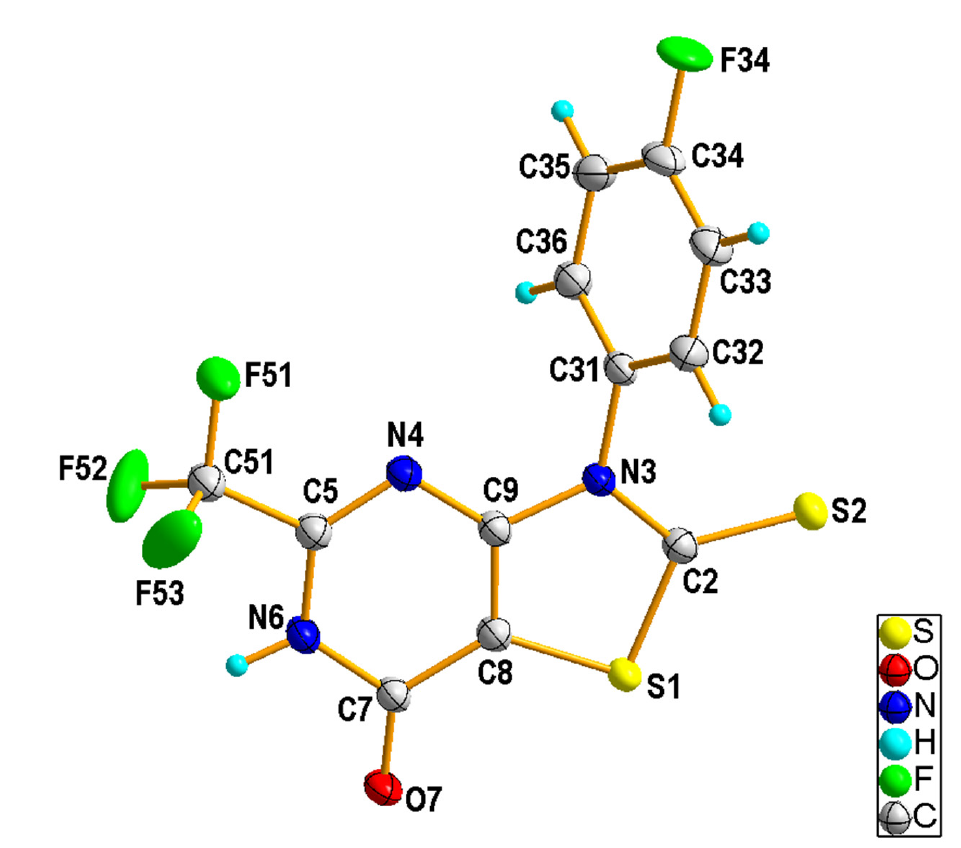
Figure 2. Crystal structure of the 2e molecule showing the atom-numbering scheme and displacement ellipsoids drawn at the 50% probability level. The disordered toluene molecule was removed for clarity.